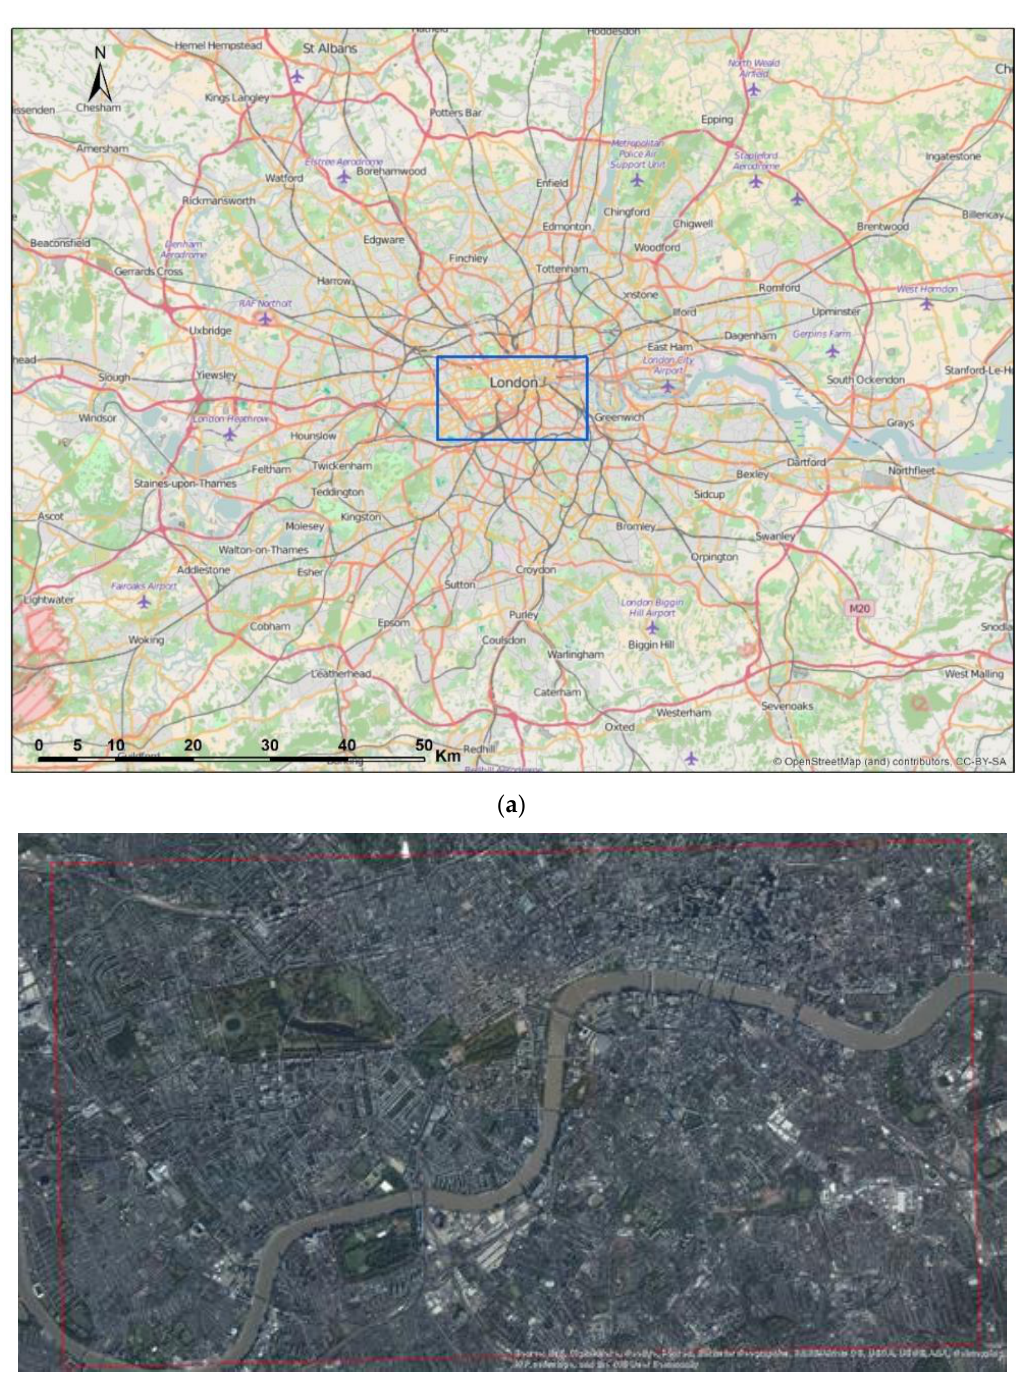
Figure 1. ( a ) OpenStreetMap, credit © OpenStreetMap contributors and ( b ) satellite image (credit © ESRI, provided base map) of the study area for examination of geo-tagged photographs from